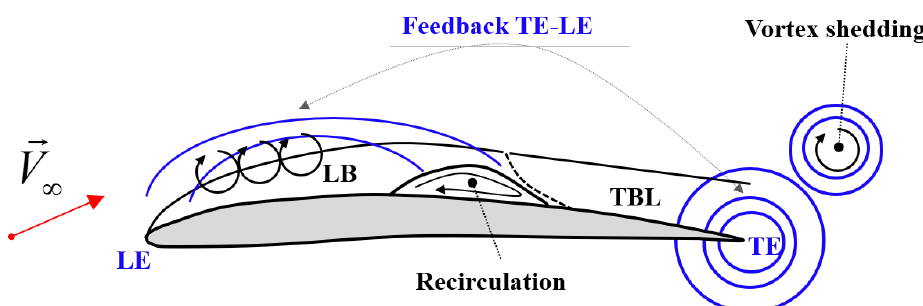
Figure 1. Schematic representation of the main broadband noise sources around an